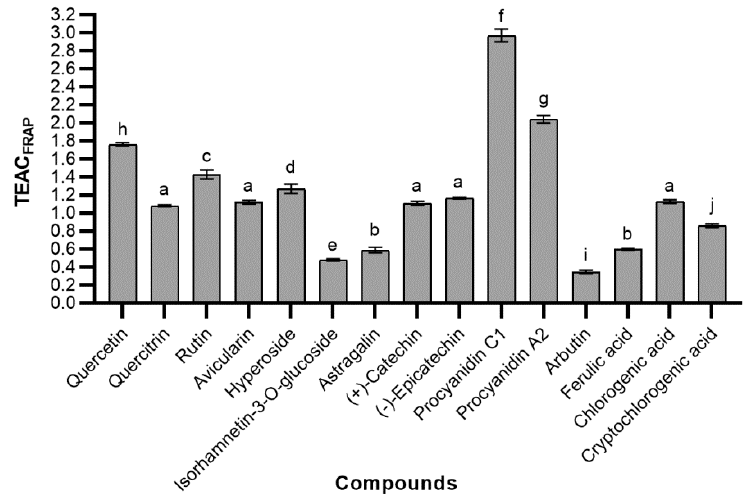
Figure 7. The reducing activity of tested phenolic compounds; bars without the same letters (a, b, c, d, e, f, g, h, i, j) indicate statistically significant differences between the means ( p < 0.05).